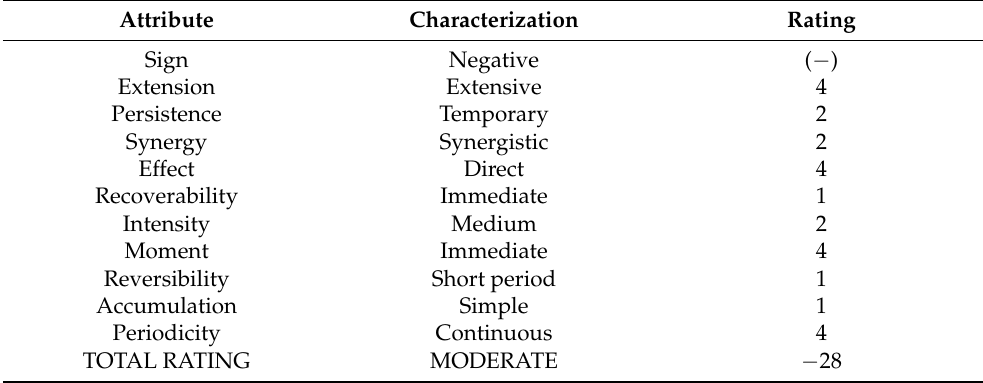
Table 4. Assessment of the impact on submarine noise during the construction phase. Attribute